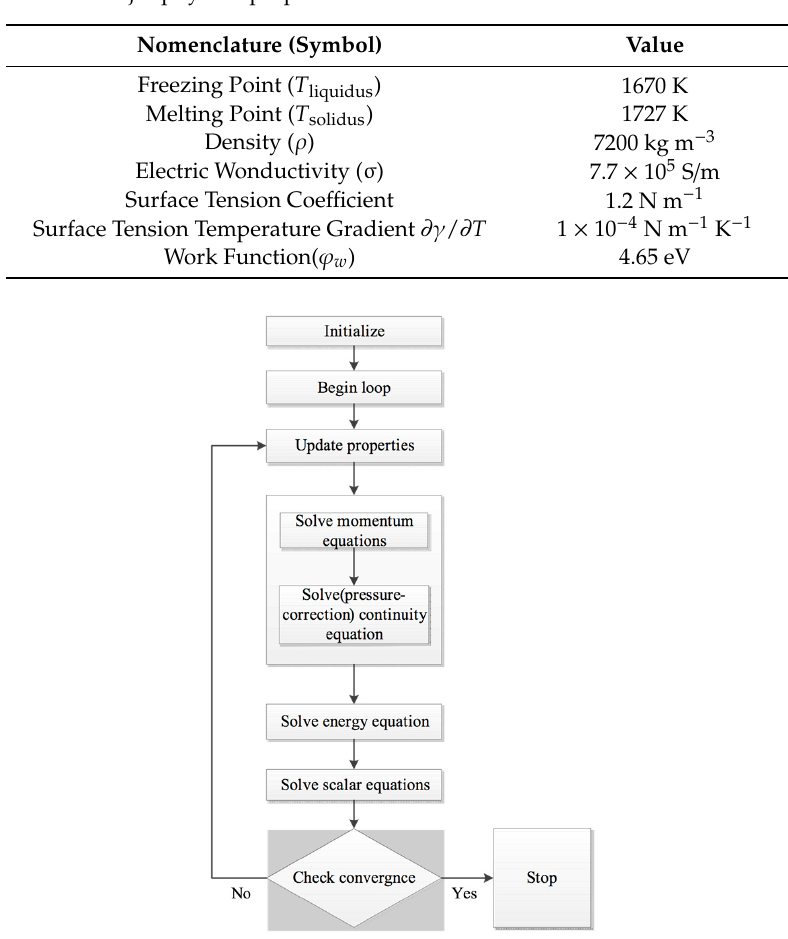
Table 2. Major physical properties of SUS304 stainless steel used in this model.